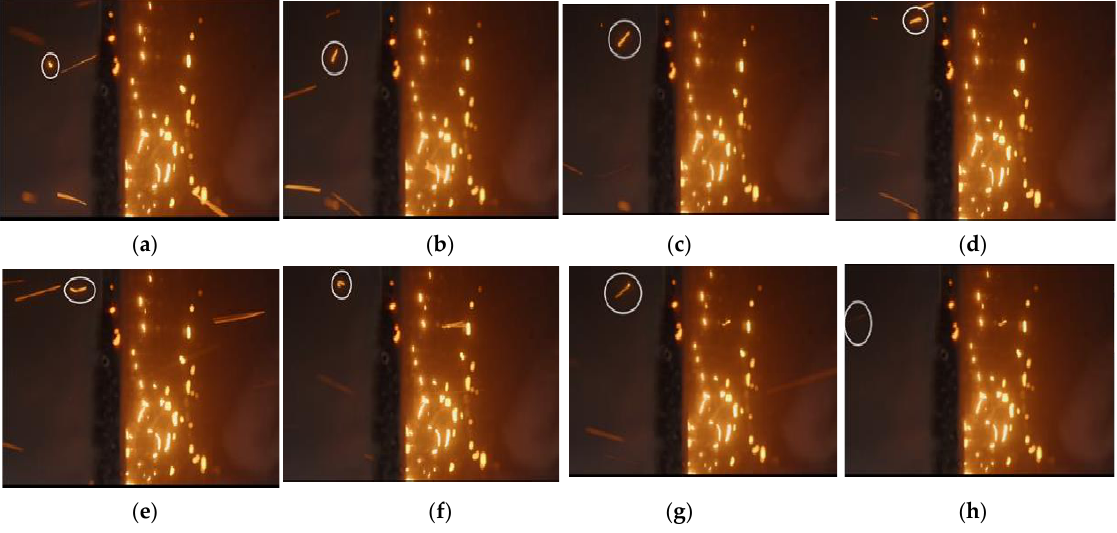
Figure 6. Firebrand shower in the wind tunnel ( a ) low intensity when no mesh was used, ( b ) high intensity when no mesh was used, ( c ) low intensity when no mesh was used, and ( d ) a typical size and shape of firebrands when the mesh was used.